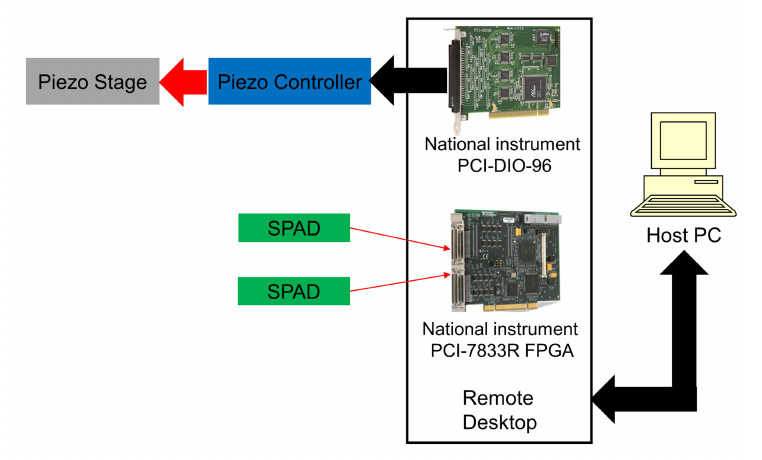
Figure 2. Description of the real-time control